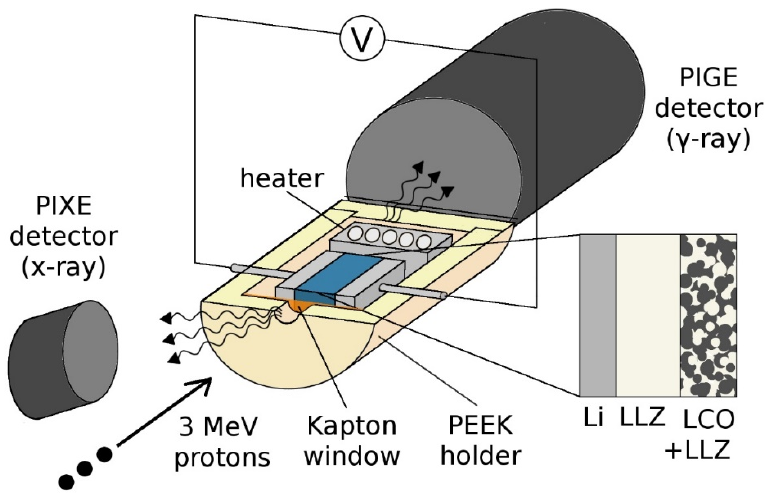
Figure 8. Side view of the analysis setup with outside connections for in-situ charging. Photon detectors are positioned behind (PIGE) and in front of the sample at 45° (PIXE). A 7.5-µm-thick beam entrance window allows for sample transport and analysis under protective atmosphere. The light yellow parts are made from PEEK, grey parts from Al, screws from stainless steel. The right side shows a zoom to the cell details with typically two cells installed in a single holder.